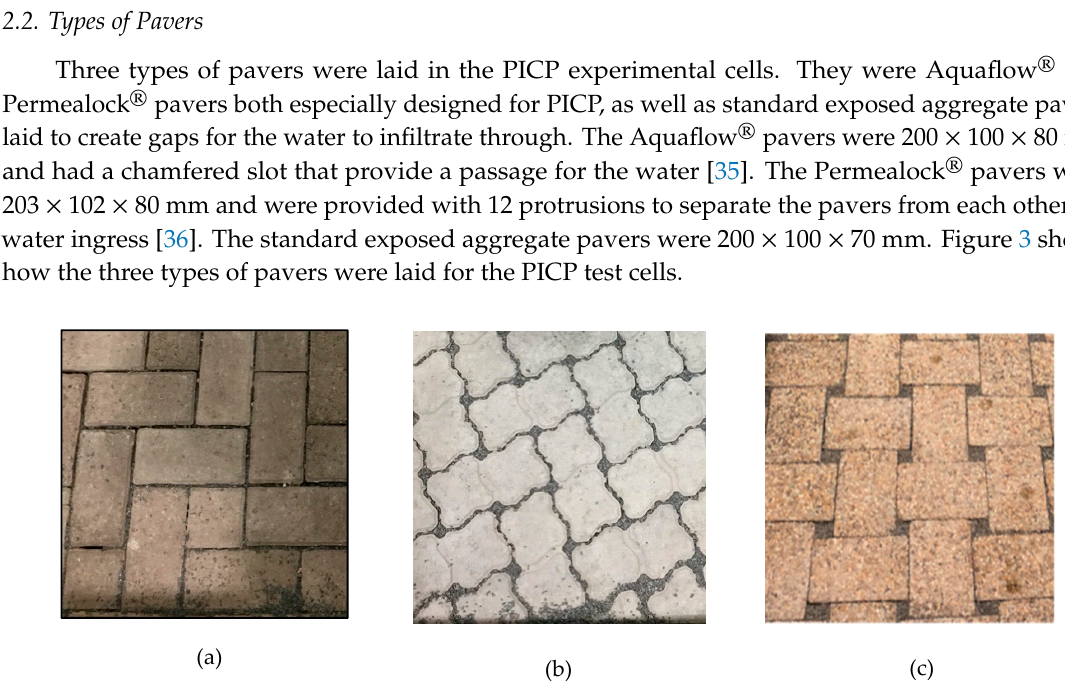
Figure 3. Paver types: ( a ) Aquaflow ® ; ( b ) Permealock ® ; and ( c ) standard exposed aggregate.